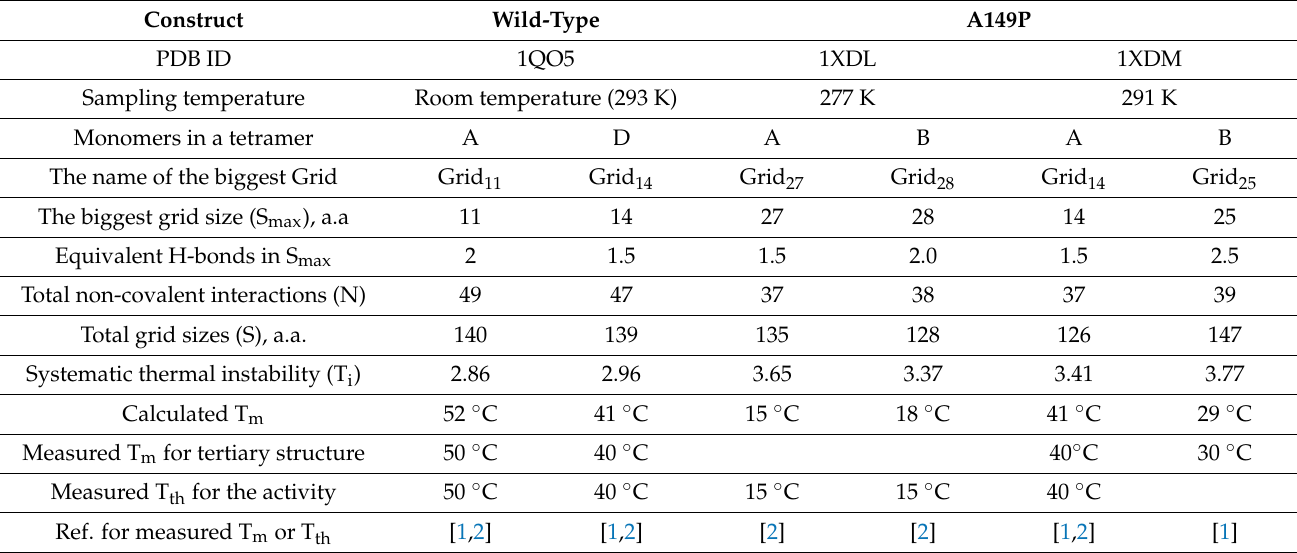
Table 1. New parameters of the ligand-free aldolase B based on the grid thermodynamic